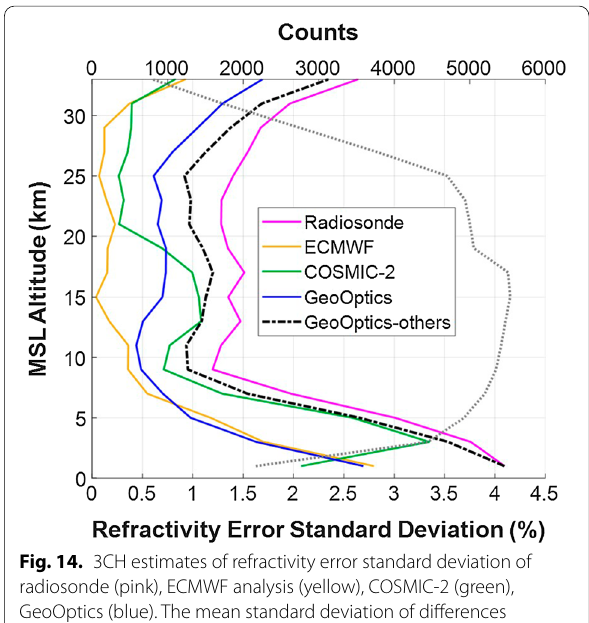
under the assumption in the 3CH method that the errors of the data sets are uncorrelated. The radiosonde, ECMWF and COSMIC-2 also have three estimates of error variance. The solid curves in Fig. 14 are the mean of the three standard deviation estimates for radio- sonde (pink), ECMWF (yellow), COSMIC-2 (green) and GeoOptics (blue). The mean standard deviation of “ GeoOptics − others ” are also shown as the black dash-dotted curve in Fig. 14 and are estimated by averaging the standard devia- tions of the apparent errors between GeoOptics data and other data sets (i.e., averaging σ GeoOptics − ECMWF , σ GeoOptics − COSMIC2 and σ GeoOptics − radiosonde ). The 3CH estimates of the GeoOptics error standard deviation (blue curve) were always lower than the standard devia- tions of the difference between GeoOptics and the other data sets (black dash-dotted curve). This indicates that apparent errors are always larger than true errors; there- fore, the estimates of true errors were reasonable by sat- isfying Eq. (5). For these data sets, the ECMWF generally have the lowest standard deviation, which is reasonable considering that ECMWF uses a data assimilation system that assimilates numerous independent observations. The radiosonde has the highest standard deviation at all altitudes, mainly due to the representativeness errors of the radiosonde, which provide point measurements while = σ 2 + σ 2 σ 2 (5) GeoOptics others GeoOptics − others